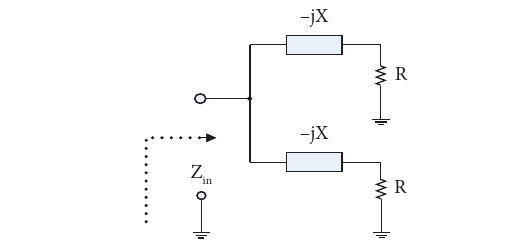
Figure 9: Te another modifed RCN (two identical reactance components).